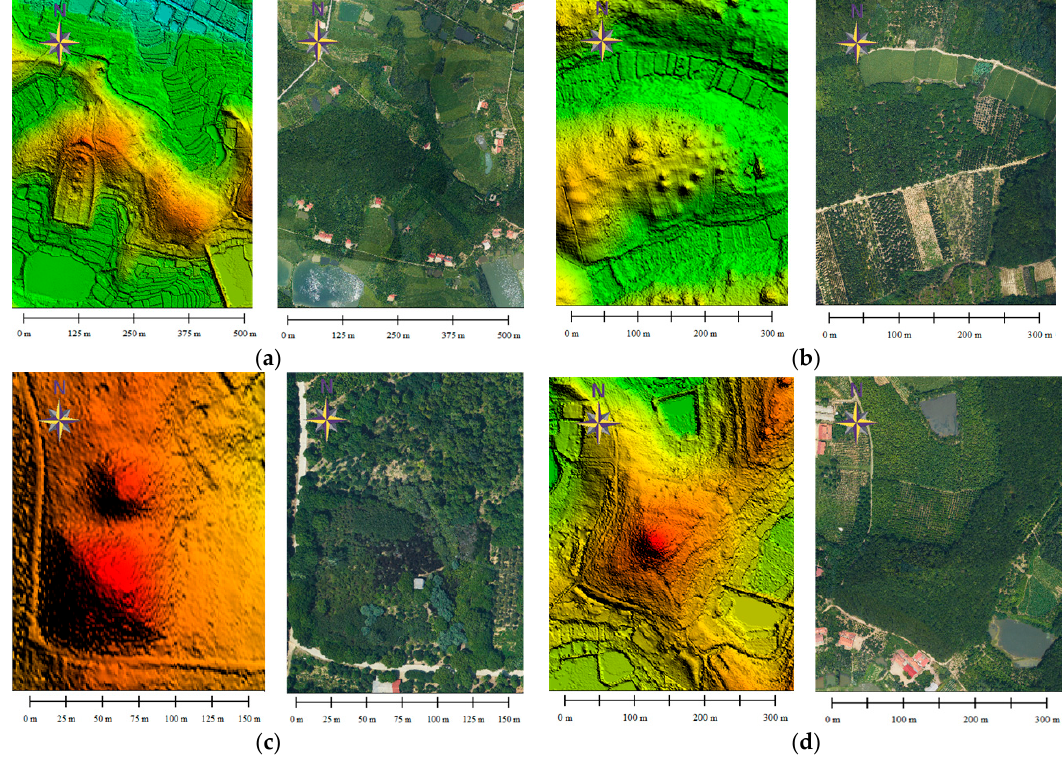
Figure 10. Typical Chu tombs: ( a ) trapezoidal tomb; ( b ) tomb group; ( c ) tomb with two mounds; and ( d ) pyramid mound.